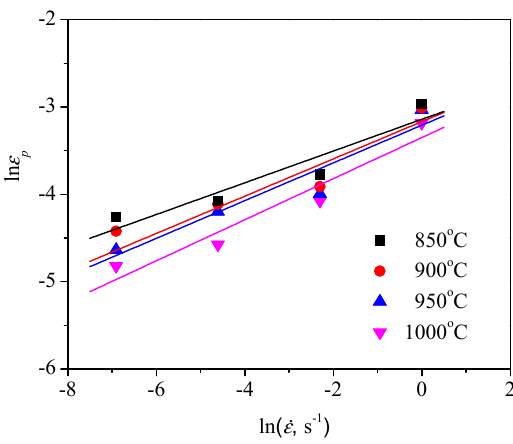
Figure 11. Relationship between the peak strain ( ε p ) and strain rate (